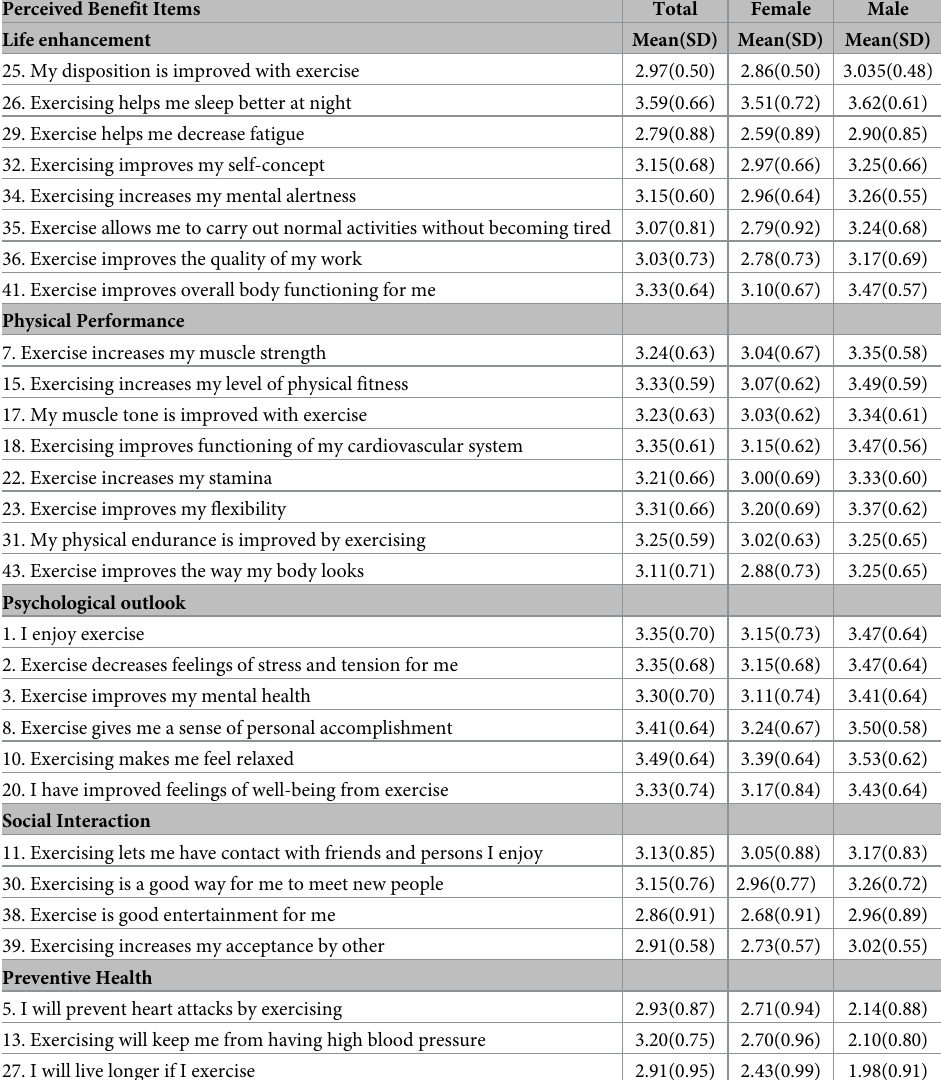
Table 5. Perceived exercise benefit sub-scales among urban female and male diabetic patients in Nepal (n =